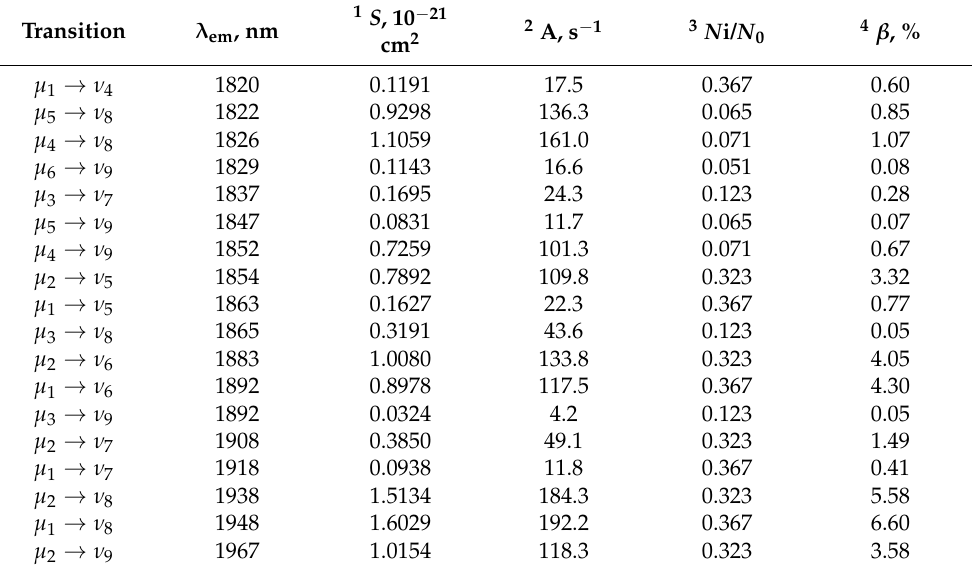
Table 2. Spectroscopic characteristics of the anti-Stokes Luminescence (ASL) spectrum at room